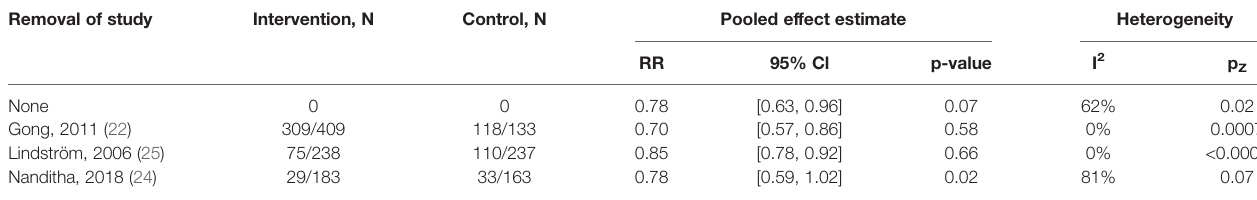
TABLE 3 | The sensitivity analysis outcomes of diabetes incidence in extended follow-up studies. Removal of